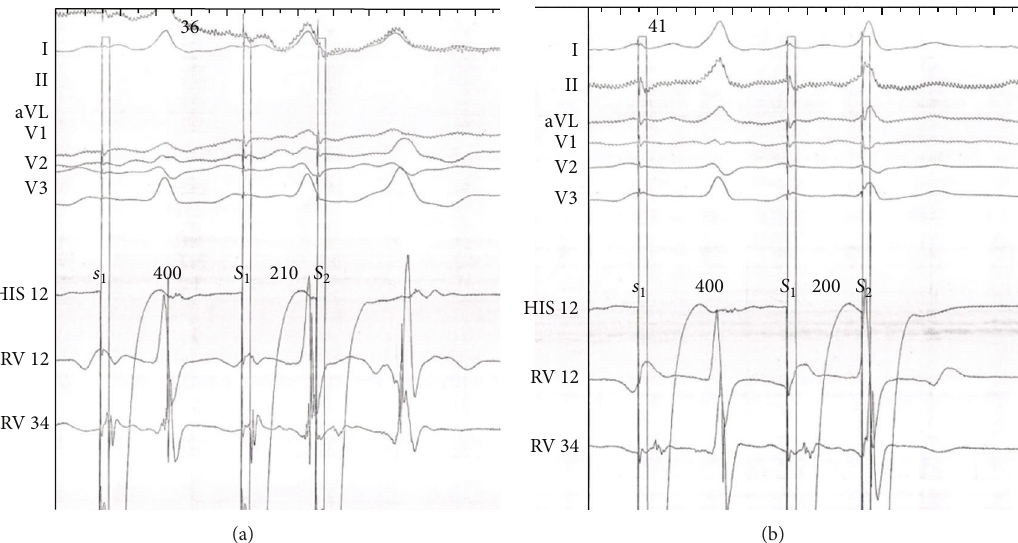
Figure6: In atrialpacing, effective accessory pathway refractory periodwas 290 mseffective ((a)and(b)). TheQRShad thesamemorphology during atrial